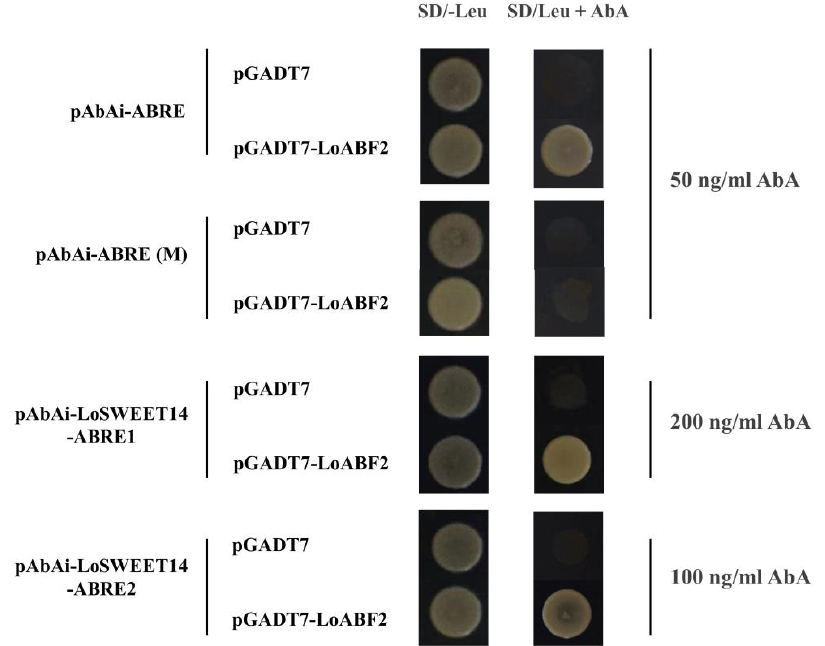
Figure 8. Yeast one-hybrid assay of interaction between LoABF2 gene and the promoter of LoSWEET14 . Y1H yeast strains were co-transformed into the prey vector pGADT7-LoABF2 with bait pAbAi-ABRE, pAbAi-ABRE(M), pAbAi-LoSWEET14-ABRE1 and pAbAi-LoSWEET14-ABRE2, respectively, and cultured on SD/ − Leu medium containing AbA with corresponding concentration, with pGADT7 empty vector used as the negative control.